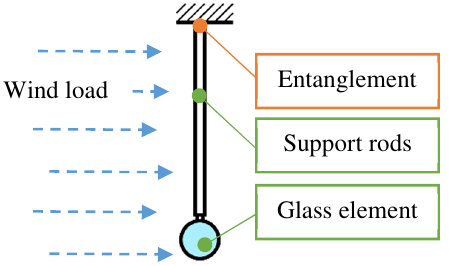
Fig. 3. Configuration for the computation.